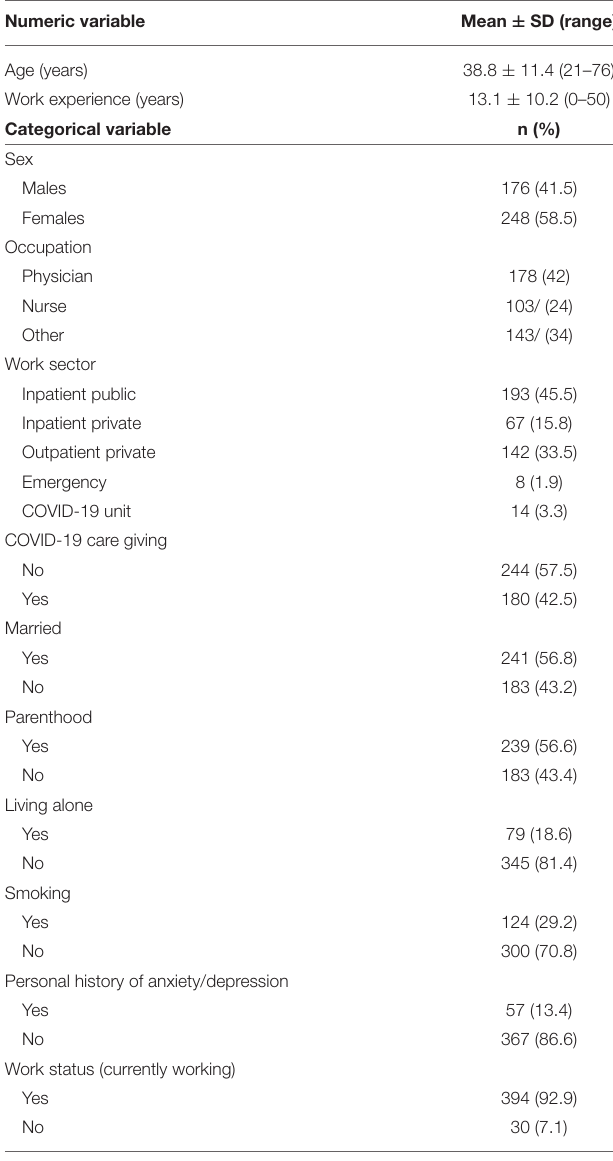
TABLE 2 | Participants’ demographics, occupational variables, and clinical characteristics ( N =